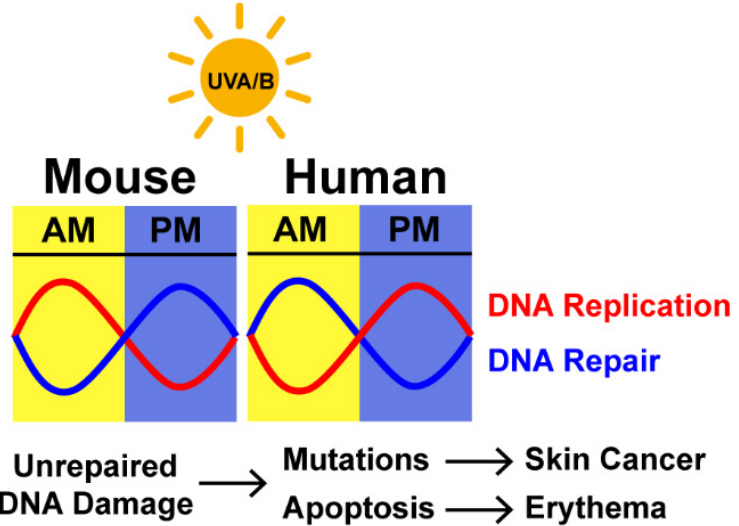
Figure 6. DNA replication and nucleotide excision repair in the skin display circadian rhythmicity. Studies in mice showed that XPA expression, UV photoproduct removal by NER, and DNA synthesis display circadian rhythmicity. Thus, XPA protein levels and NER are low in the early morning hours (AM) when DNA replication is high. In the afternoon and evening (PM), XPA expression and NER are high and rates of DNA replication are low. Thus, unrepaired UV photoproducts are more problematic in the early morning hours and lead to increased mutagenesis, carcinogenesis, apoptosis, and erythema. The phases of these rhythmic processes are expected to display the opposite phase in humans. Indeed, DNA synthesis has been shown to display circadian rhythmicity in human skin epidermis, such that DNA replication peaks in the mid-afternoon.